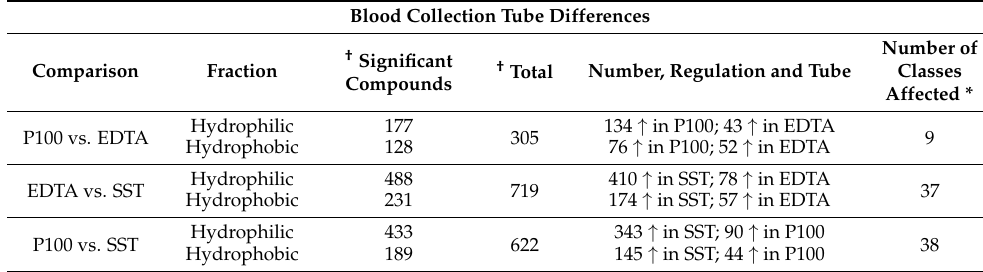
Table 2. Comparison of metabolites extracted from various collection tubes at the control time point. Metabolites in the control plasma tubes (P100, EDTA, 0 min post-collection) and control serum tubes (SST, 30 min post-collection) were compared to identify differences in metabolite abundance across tubes. * Chemical classes with FDR ≤ 0.05 and ≥ 3 matched entities following taxonomy enrichment. † ANOVA with Tukey HSD post hoc test, Bonferroni FWER ≤ 0.05 and fold change ≥ 1.5.